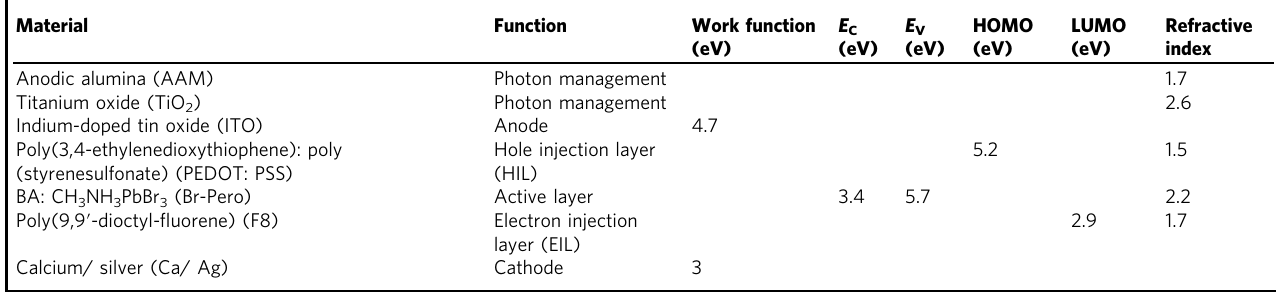
Table 1 Material details for the Br-Pero nanophotonic LED device structure Material